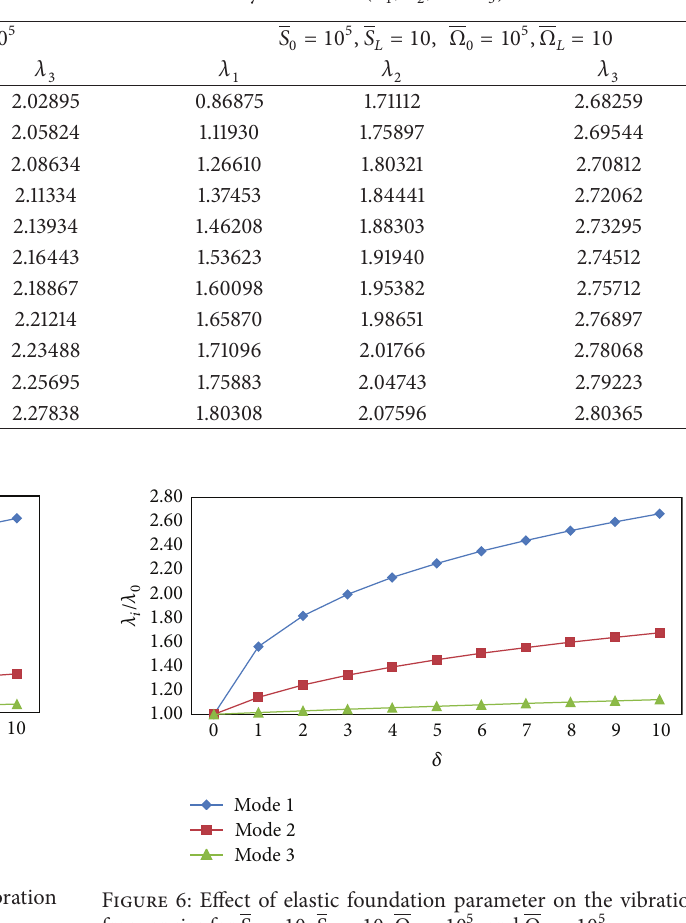
Table 5: The first three frequency parameters for different boundary conditions ( 𝜆 1 , 𝜆 2 , and 𝜆 3 ).